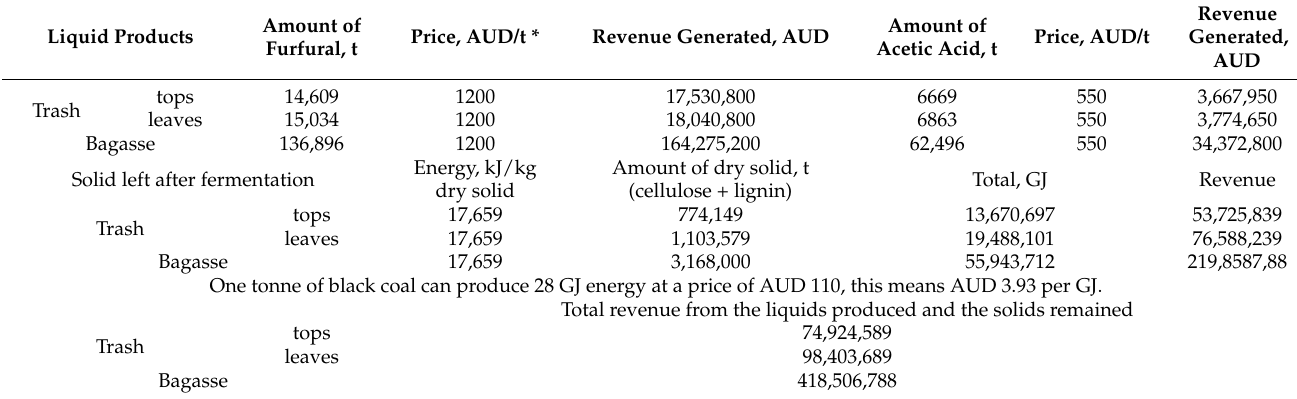
Table 19. Potential revenue of furfural produced from trash and